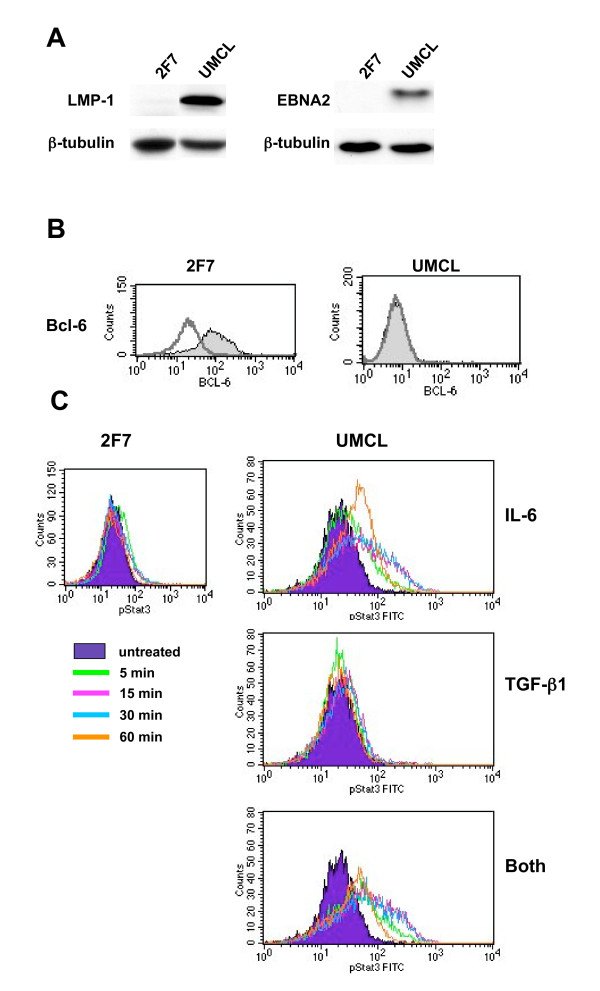
(A). Immunoblot analysis of LMP-1 and EBNA2 expression in 2F7 and UMCL01-101 (UMCL) cell lines. The expression of β-tubulin was examined as a loading control. (B). Bcl-6 expression in 2F7 and UMCL01-101 (UMCL) cell lines as examined by intracellular flow cytometry. The shaded and open histograms represent analysis with Bcl-6 antibody and isotype control antibody, respectively. (C). Activated (phosphorylated) STAT3 in 2F7 and UMCL01-101 cell lines. 2F7 cells were treated with IL-6 (20 ng/ml), or were untreated, for time intervals between 0 – 60 minutes. UMCL01-101 cells (UMCL) were treated with IL-6 (20 ng/ml), TGF-β1 (1 ng/ml), both, or were untreated, for time intervals between 0 – 60 minutes. Phosphorylated STAT3 (pSTAT3) was detected by intracellular flow cytometry.